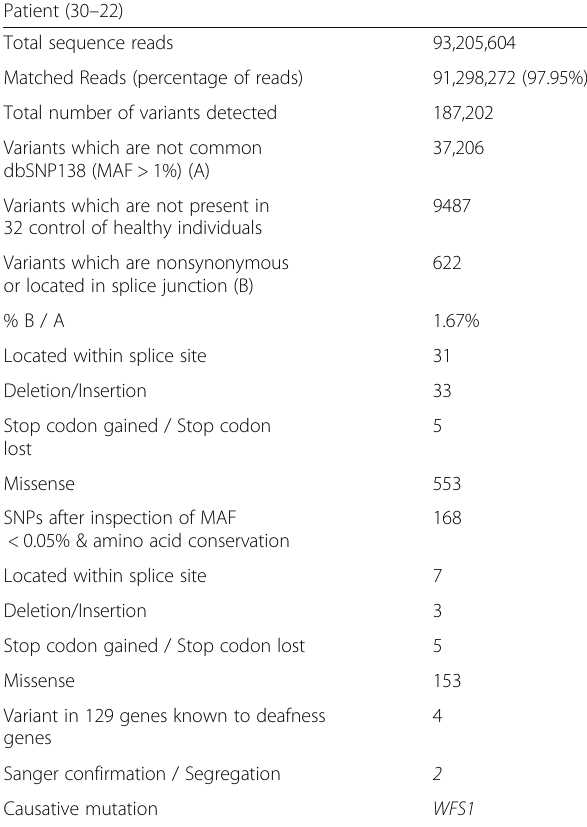
Table 1 Filtering process of whole exome sequencing analysis in this study